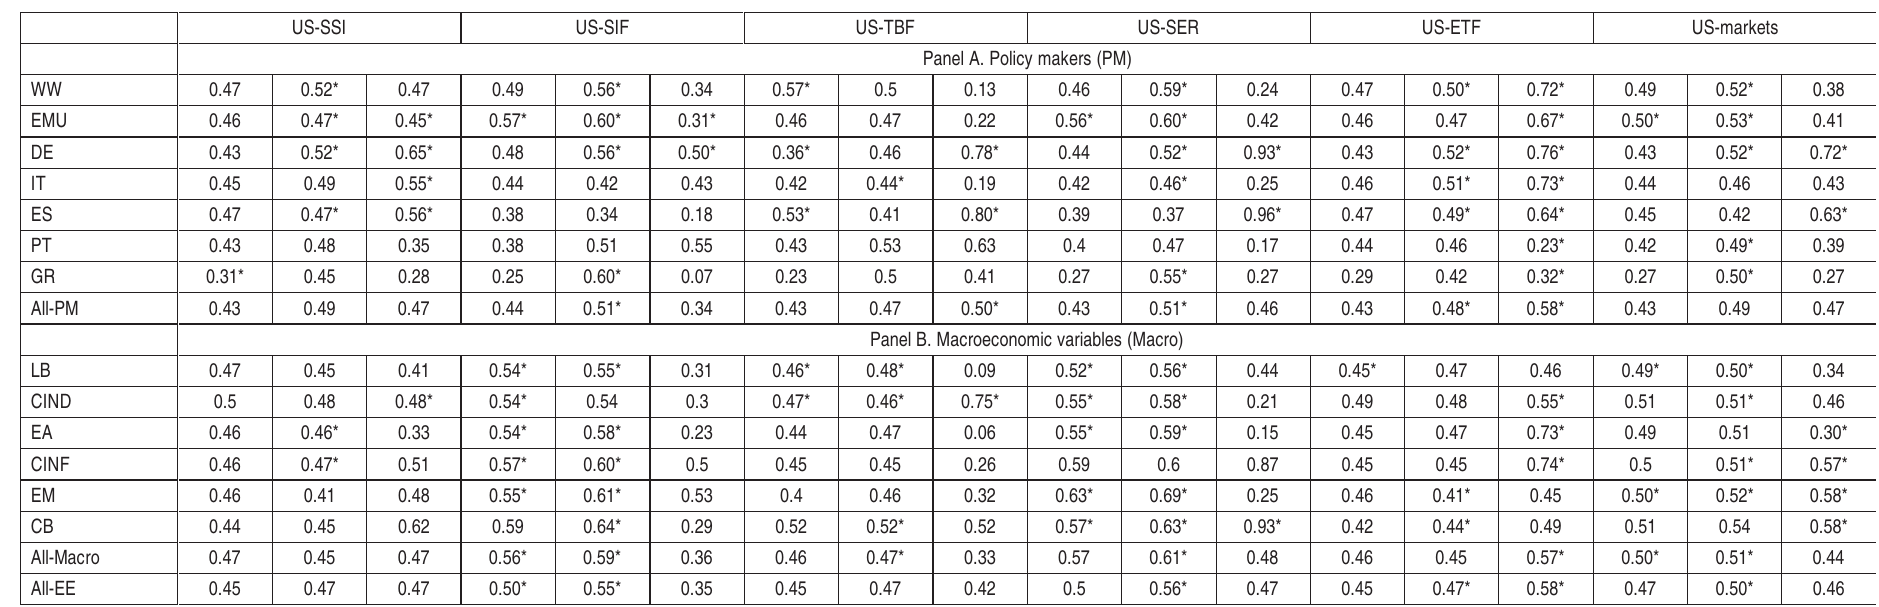
Table 6. Sharpe ratio criterion - Summarized